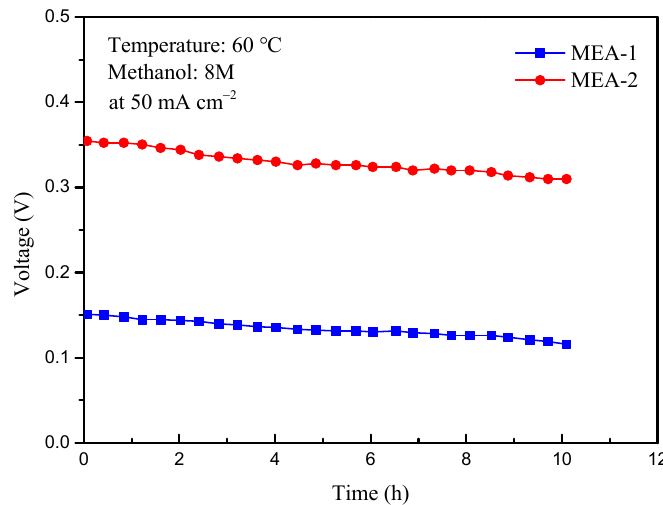
Figure 9. Long-term voltage of novel and conventional electrode at 8M concentration. Figure 9. Long ‐ term voltage of novel and conventional electrode at 8M concentration.